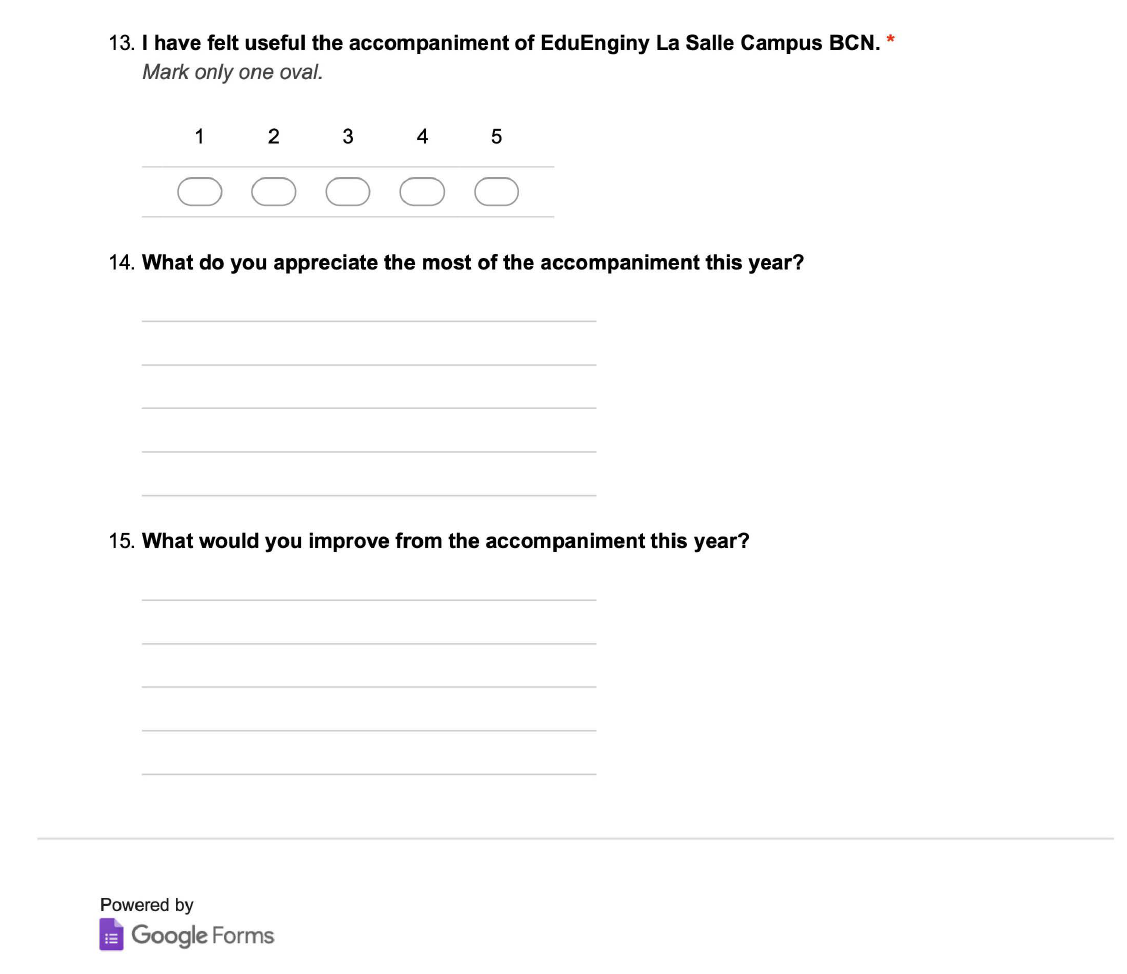
Figure A3. Questionnaire delivered to the teachers participating in this study after the